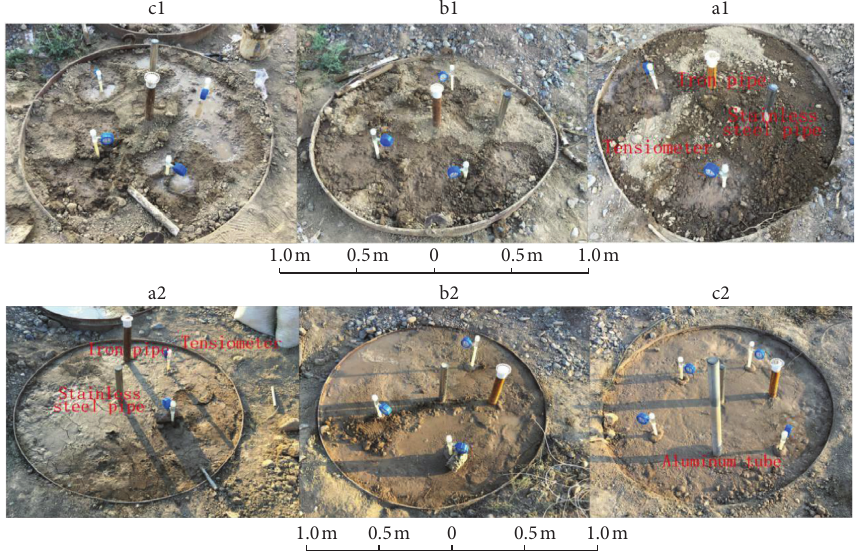
Figure 3: Test barrels.